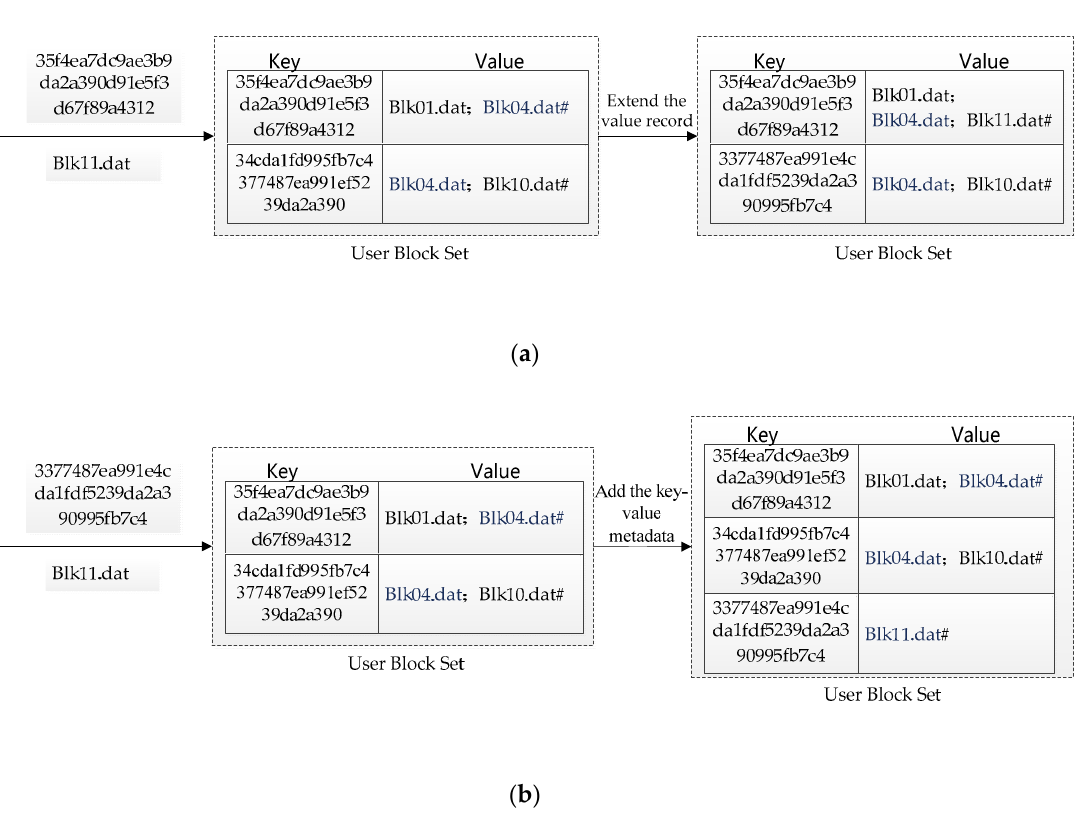
Figure 10. Examples of “User Block Set” extension algorithm: ( a ) The extended UserAddress exists in the metadata, extending the value record; ( b ) The extended UserAddress does not exist in the metadata, new metadata is added.